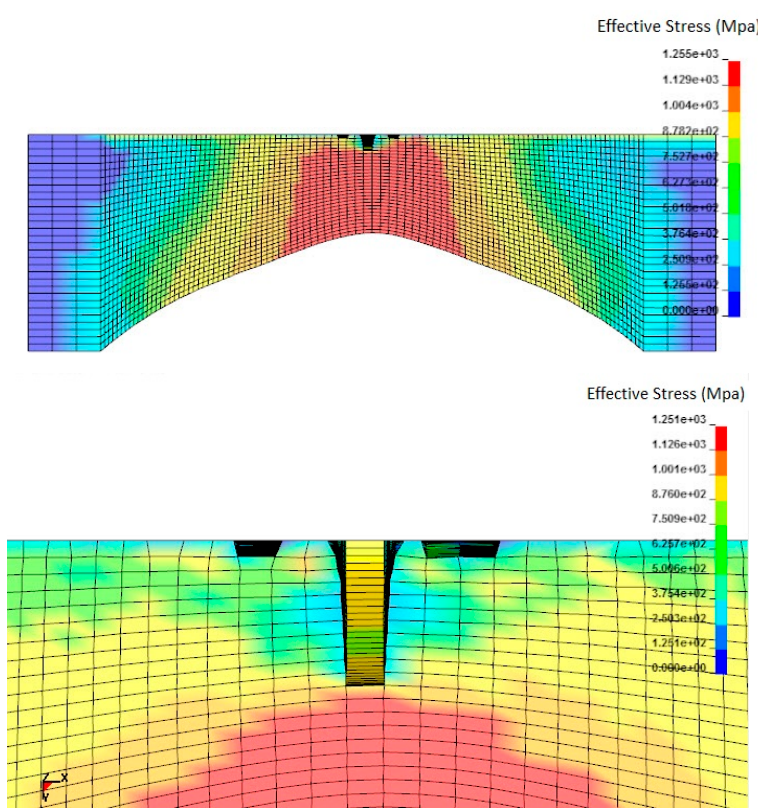
Figure 15. The location of voids’ initiation and coalescence predicted by GTN Model.